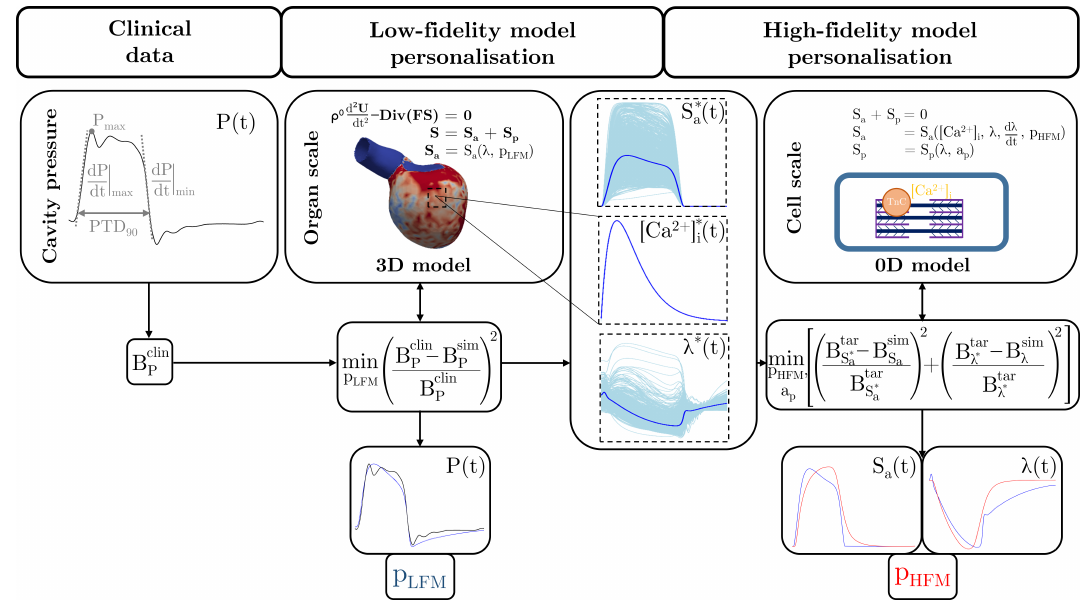
Figure 2. Conceptual illustration of the two-step multi-fidelity approach for personalising biophys- ically detailed active mechanics models. In the first step, the active mechanical behaviour in the given 3D EM model is described by a low-fidelity model (LFM). This is personalised at the organ scale by minimising the difference between simulated (sim) and clinical (clin) pressure biomarker values ( B P ) that are obtained from an available clinical cavity pressure trace. Median traces of nodal cellular active stress ( S ∗ a ), intracellular calcium concentration ( [ Ca 2 + ] ∗ ), and fibre stretch ( λ ∗ ) are i then obtained from the simulation that was produced by the personalised 3D EM models. These are utilised to personalise the high-fidelity model (HFM) at the cell scale in the second step. To this end, the HFM model is integrated in an 0D EM model that simulates the stretch of the cardiomyocyte during the cardiac cycle based on the equilibrium of active and passive stress. The median trace of nodal [ Ca 2 + ] i is used as input but [ Ca 2 + ] i can also be generated from a coupled model of [ Ca 2 + ] i evolution that is integrated in the chosen cellular EP model. Personalisation is done by minimising the difference between simulated (sim) and target (tar) biomarker values that are obtained from the median traces of nodal cellular active stress ( B S ∗ ) and fibre stretch ( B λ ∗ ). The parameters of the LFM a and the HFM are denoted by p LFM and p HFM , respectively. Please note that the fibre stretch in the relaxed state is 1 per definition (Section 2.3.1 and Appendix